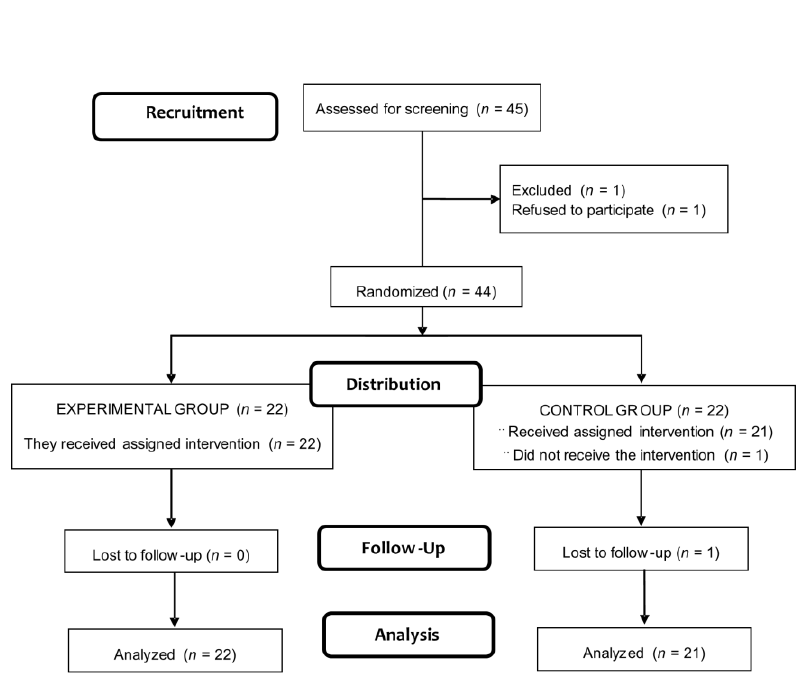
Figure 1. Flow chart of the study population.